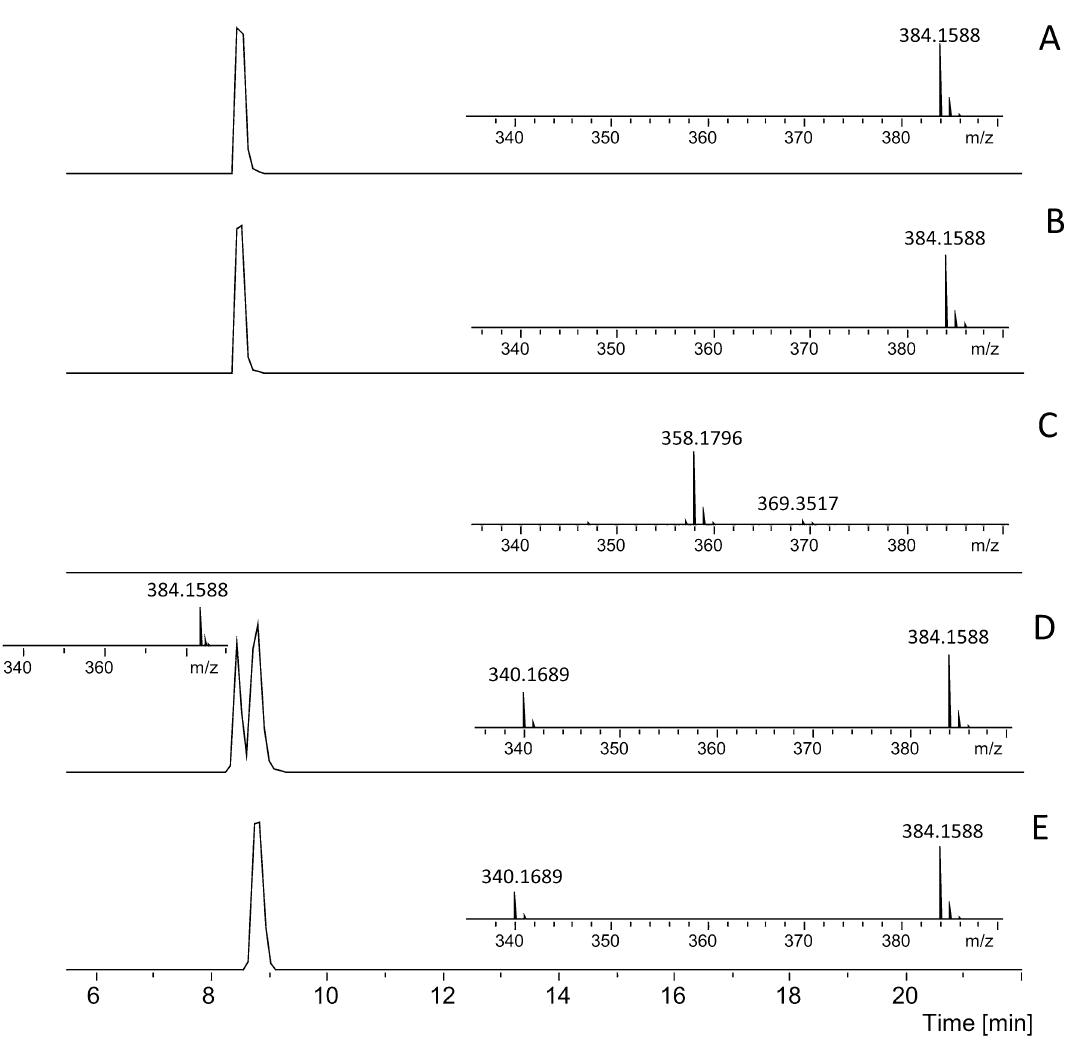
Figure 1. LC–MS analysis of meropenen before and after exposure to the different OXA-48 strains. Extracted Ion Chromatograms (EIC) of m/z = 384.15 (± 0.2Th) show retention behavior of meropenem and meropenem- derived β-lactone isomer. Insets show mass spectra from the apex of each chromatographic peak. ( A ) EIC of pure meropenem standard; ( B ) negative control, EIC of meropenem exposed only to E. coli ATCC 14,169; ( C ) positive control, EIC of meropenem exposed to strain P759. There is no chromatographic peak corresponding to meropenem, the inset mass spectrum shows degradation product at m/z = 358 at the retention time of meropenem standard; ( D ) meropenem exposed to strain P370 and partially converted to β-lactone isomer; EIC shows chromatographic resolution of original meropenem (earlier peak) and newly formed β-lactone isomer of meropenem (later peak). Inset mass spectrum for the early peak is identical with the standard meropenem spectrum and with the negative control spectrum, while mass spectrum of newly formed isomer also contains peak at m/z = 340; ( E ) meropenem exposed to strain P370 and fully converted to the β-lactone, as can be seen from the shift in retention time. Mass spectrum contains peaks at m/z = 340 and